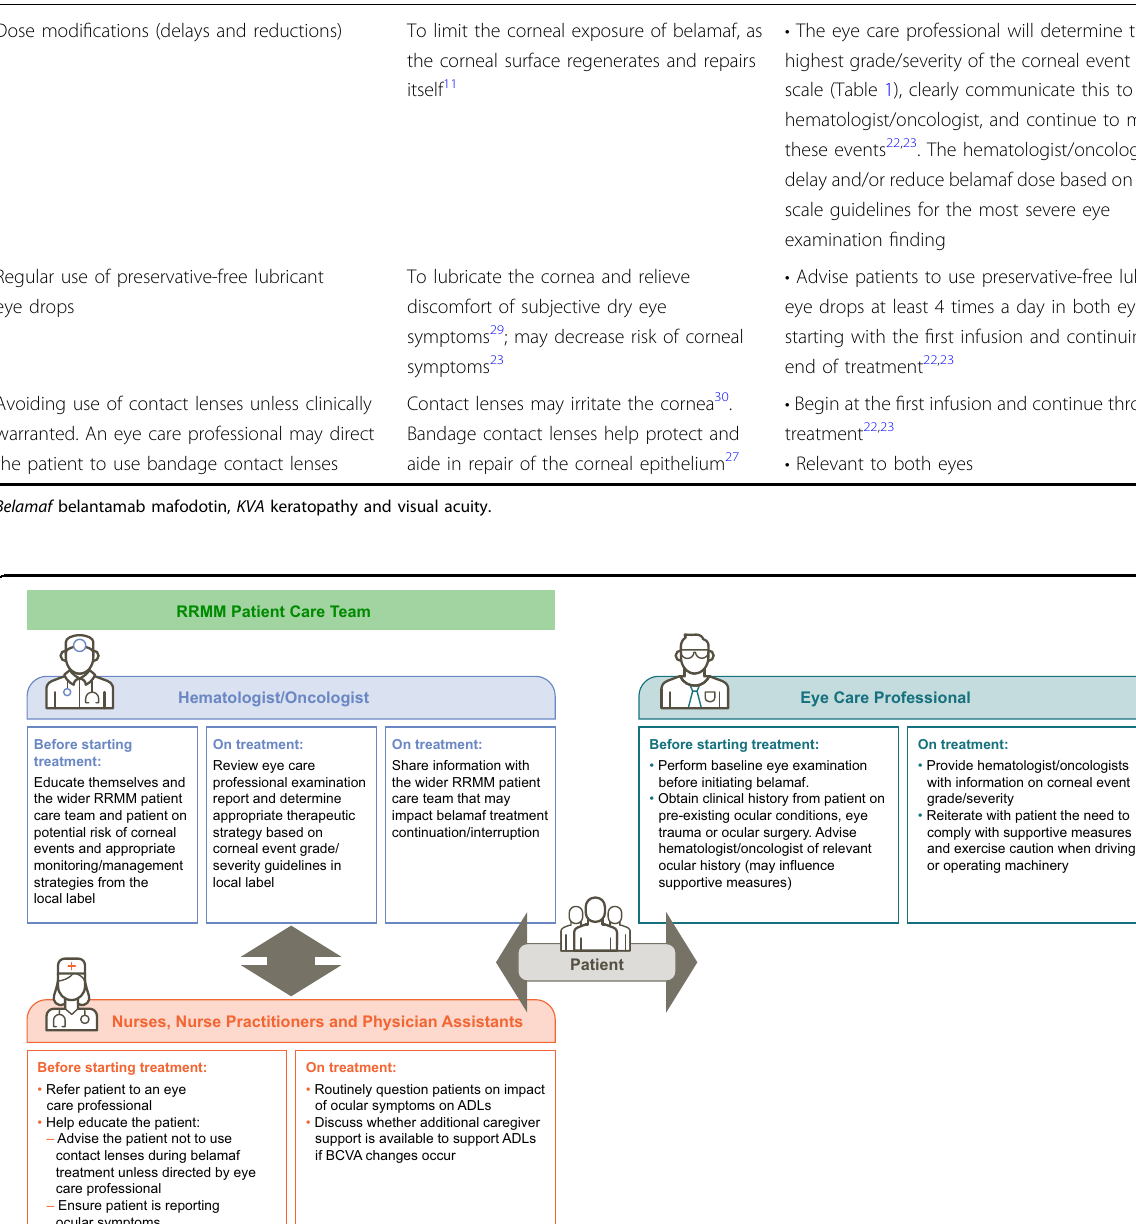
Table 2 Recommended management strategies for corneal events observed in patients receiving belamaf. Strategy